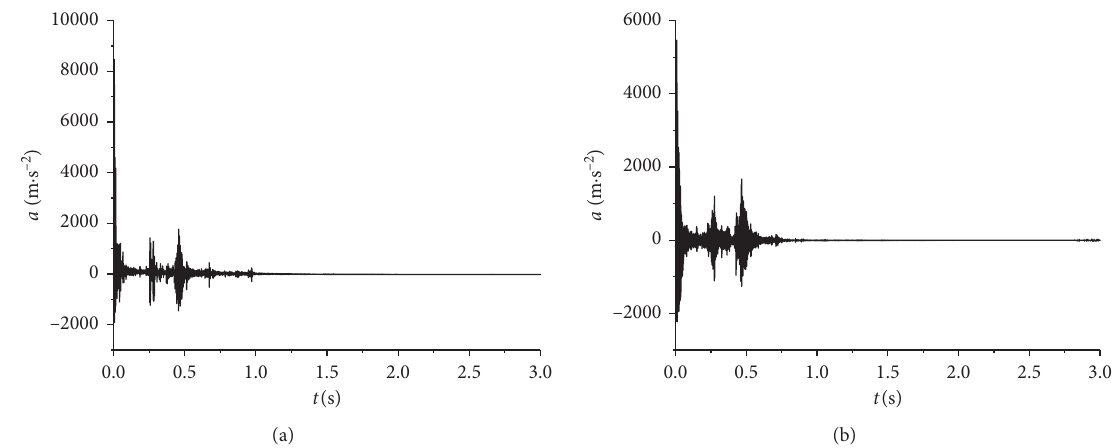
Figure 4: Measured acceleration time-history curves of spring-cylinder isolation device. (a) TQGG1. (b)